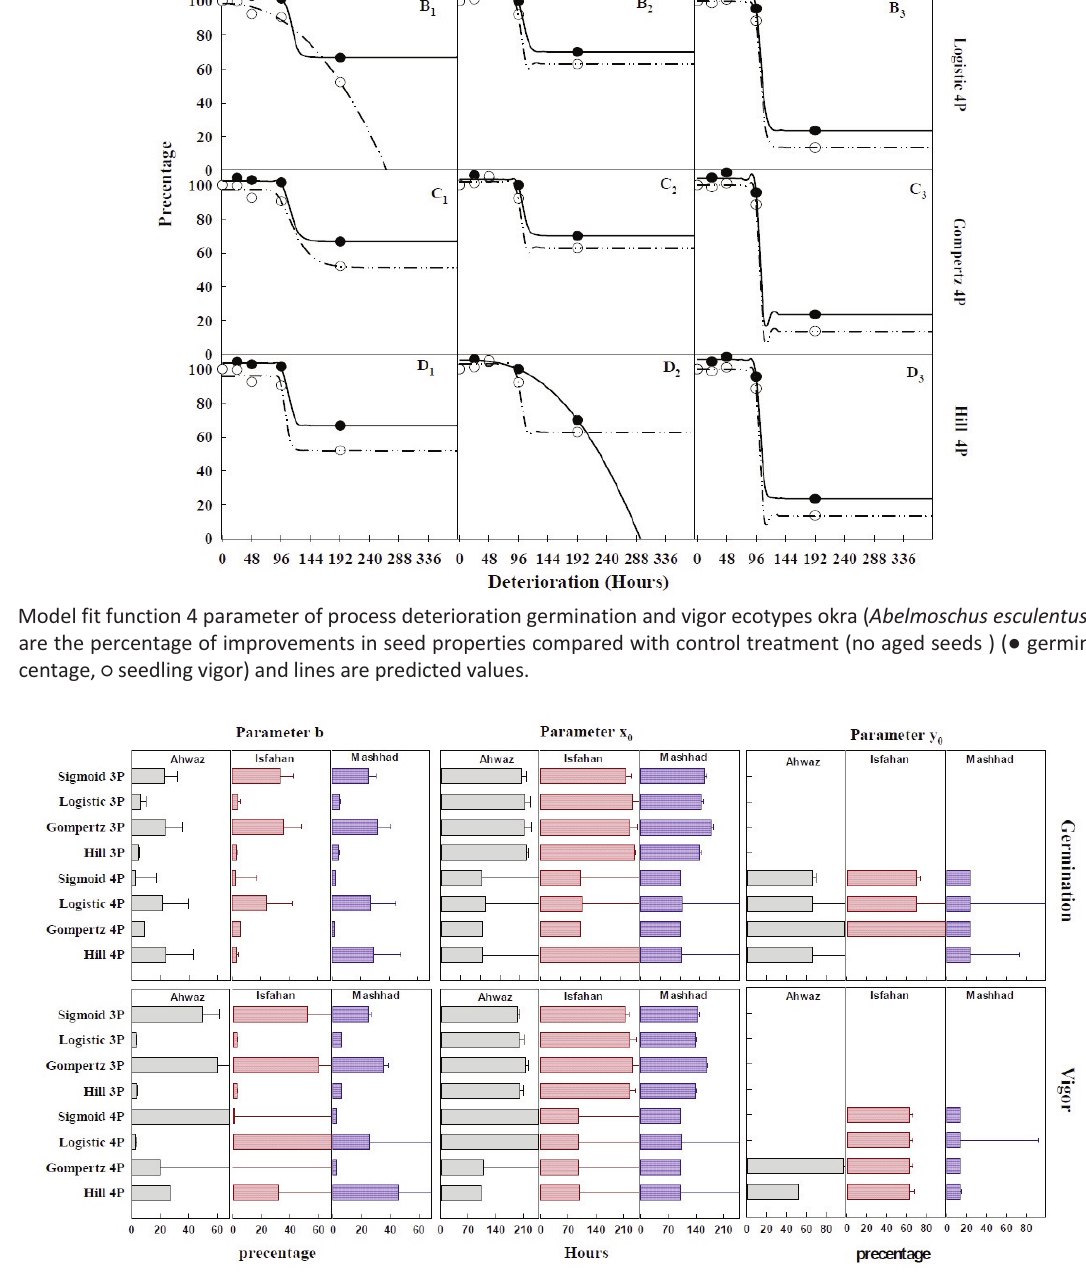
Estimate parameter of fit models process deterioration germination and vigor ecotypes okra ( Abelmoschus esculentus L.). In these models germination and vigor were considered as 100%, and parameter a, for all models was